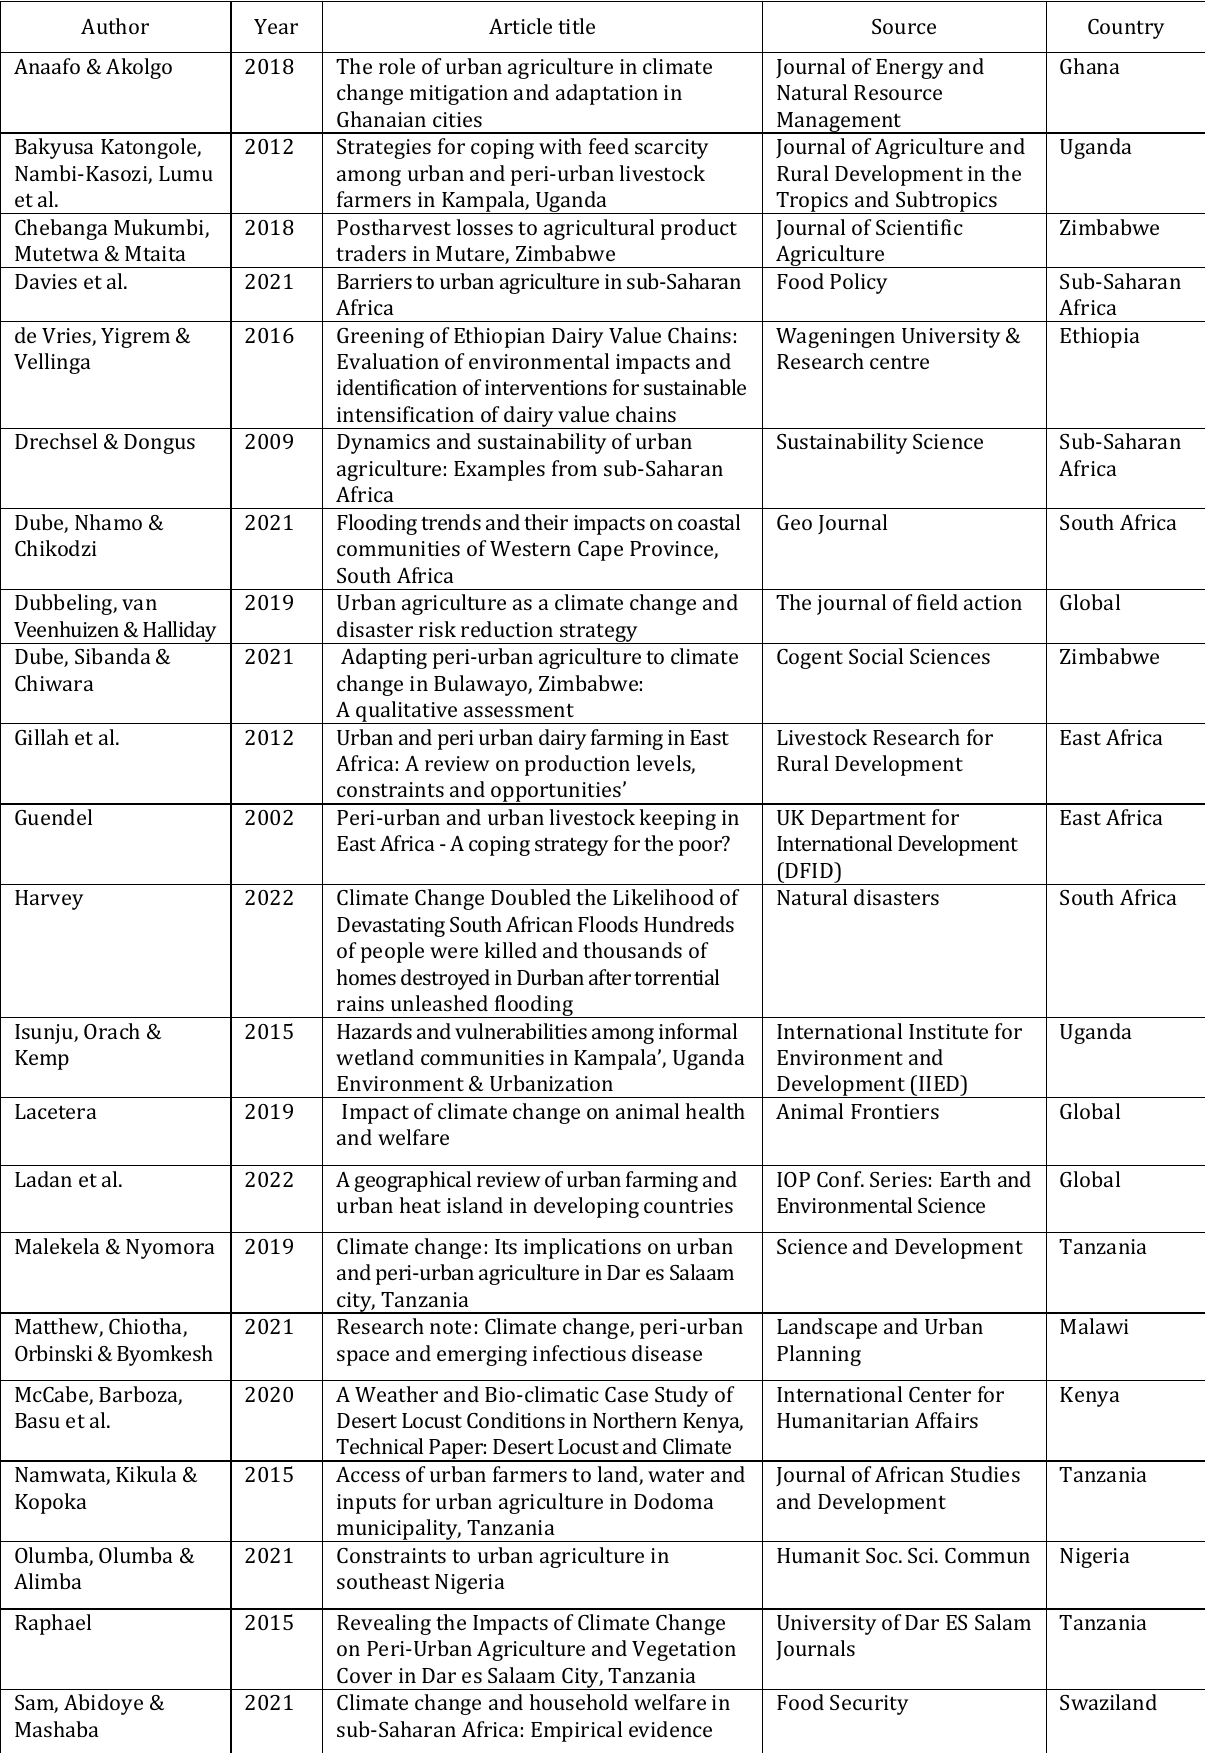
Table 1. Impact of climate change on urban agriculture in sub-Saharan